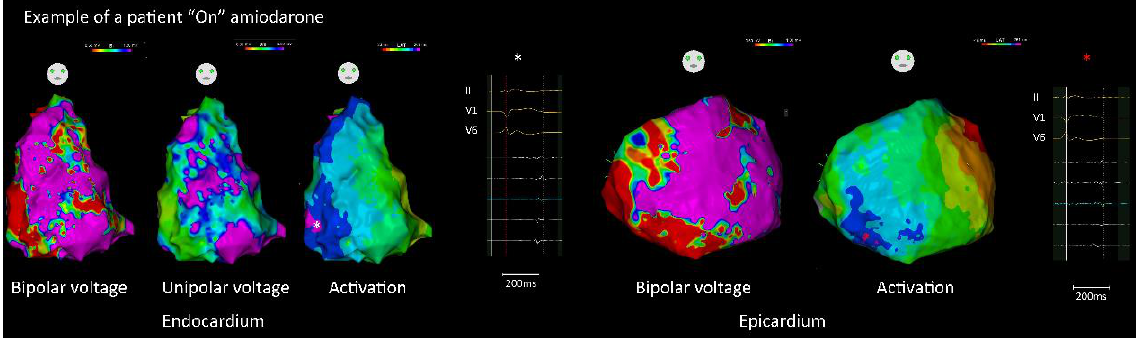
Figure 2. An example of electrophysiological and substrate characteristics in a patient “on” amio- darone before CA. Patients with ARVC “on” amiodarone had a longer total activation time and larger areas with abnormal electrograms. The ( left panel ) showed an endocardial voltage map and activation map with local abnormal electrograms. The ( right panel ) showed an epicardial voltage map and activation map with local abnormal electrograms ( * indicated the location of corresponding signal ) . “See text for details”.